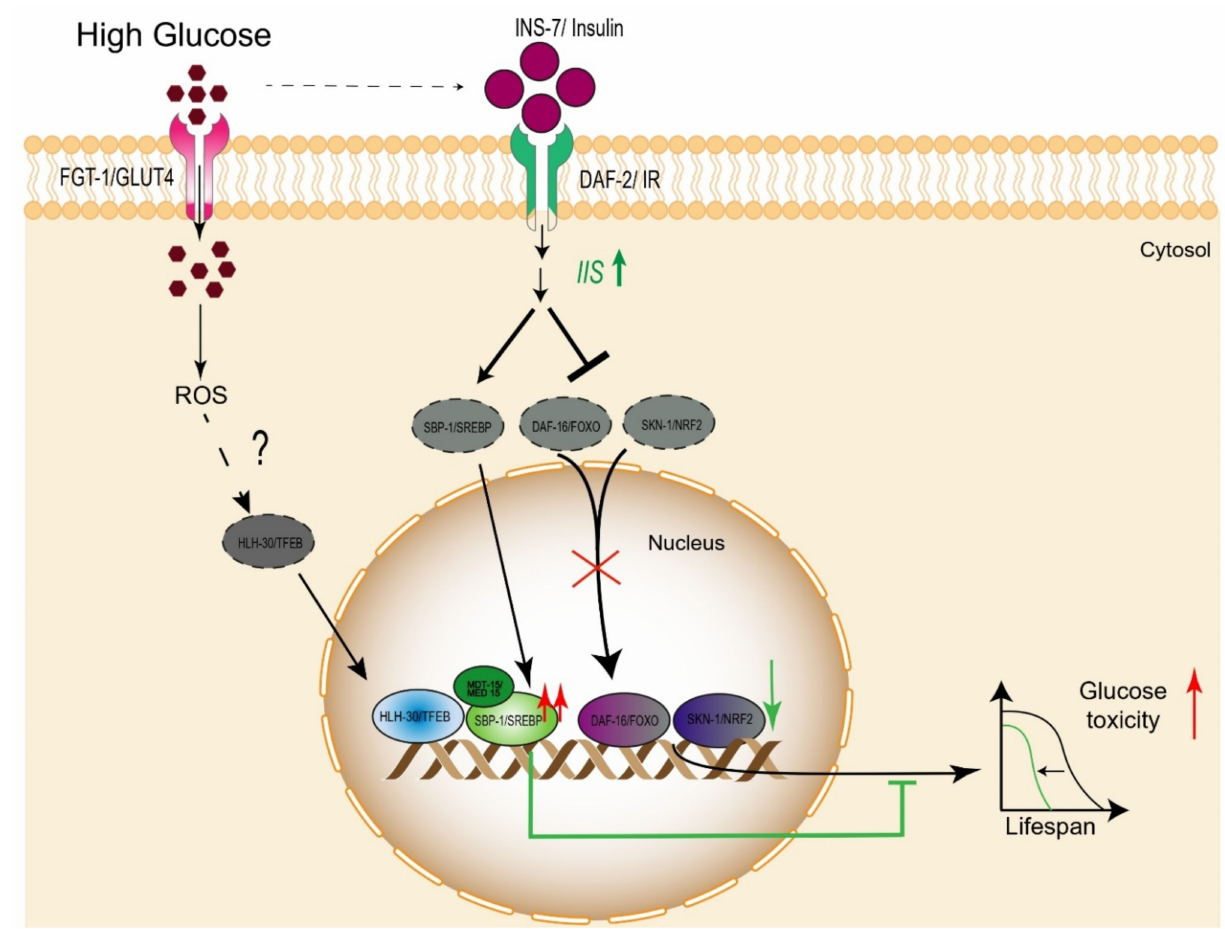
Figure 3. Dietary glucose decreases lifespan by altering cellular localization of several transcriptional factors. High glucose, probably through activation of the IIS pathway, diminishes the nuclear localization and transcriptional activity of DAF- 16/FOXO and SKN-1, which consequently decreases the worms’ lifespan. Interestingly, high glucose augments the nuclear localization of HLH-30 and SBP-1/MDT-15, although with opposite consequences, because HLH-30 decreases the lifespan whereas SBP-1/MDT-15 prevents the life-shortening effects of high